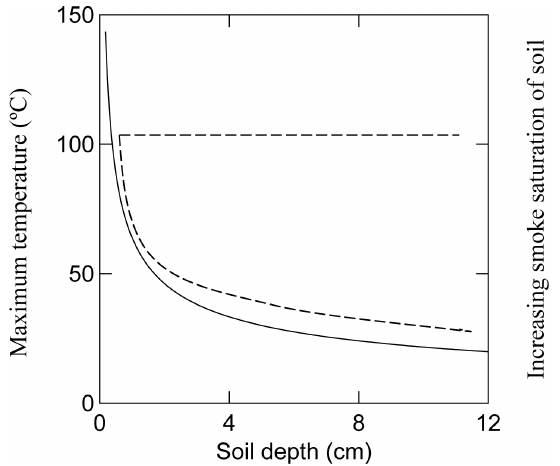
Fig. 1. Possible variation of fire cues with soil depth. Solid line – heat profile from a typical wildfire (T. D. Auld unpubl.). The dashed lines represent a range of possible relationships between smoke concentration and soil depth, varying from complete satu- ration at all depths (horizontal line) to a rapid decline in satura- tion with soil